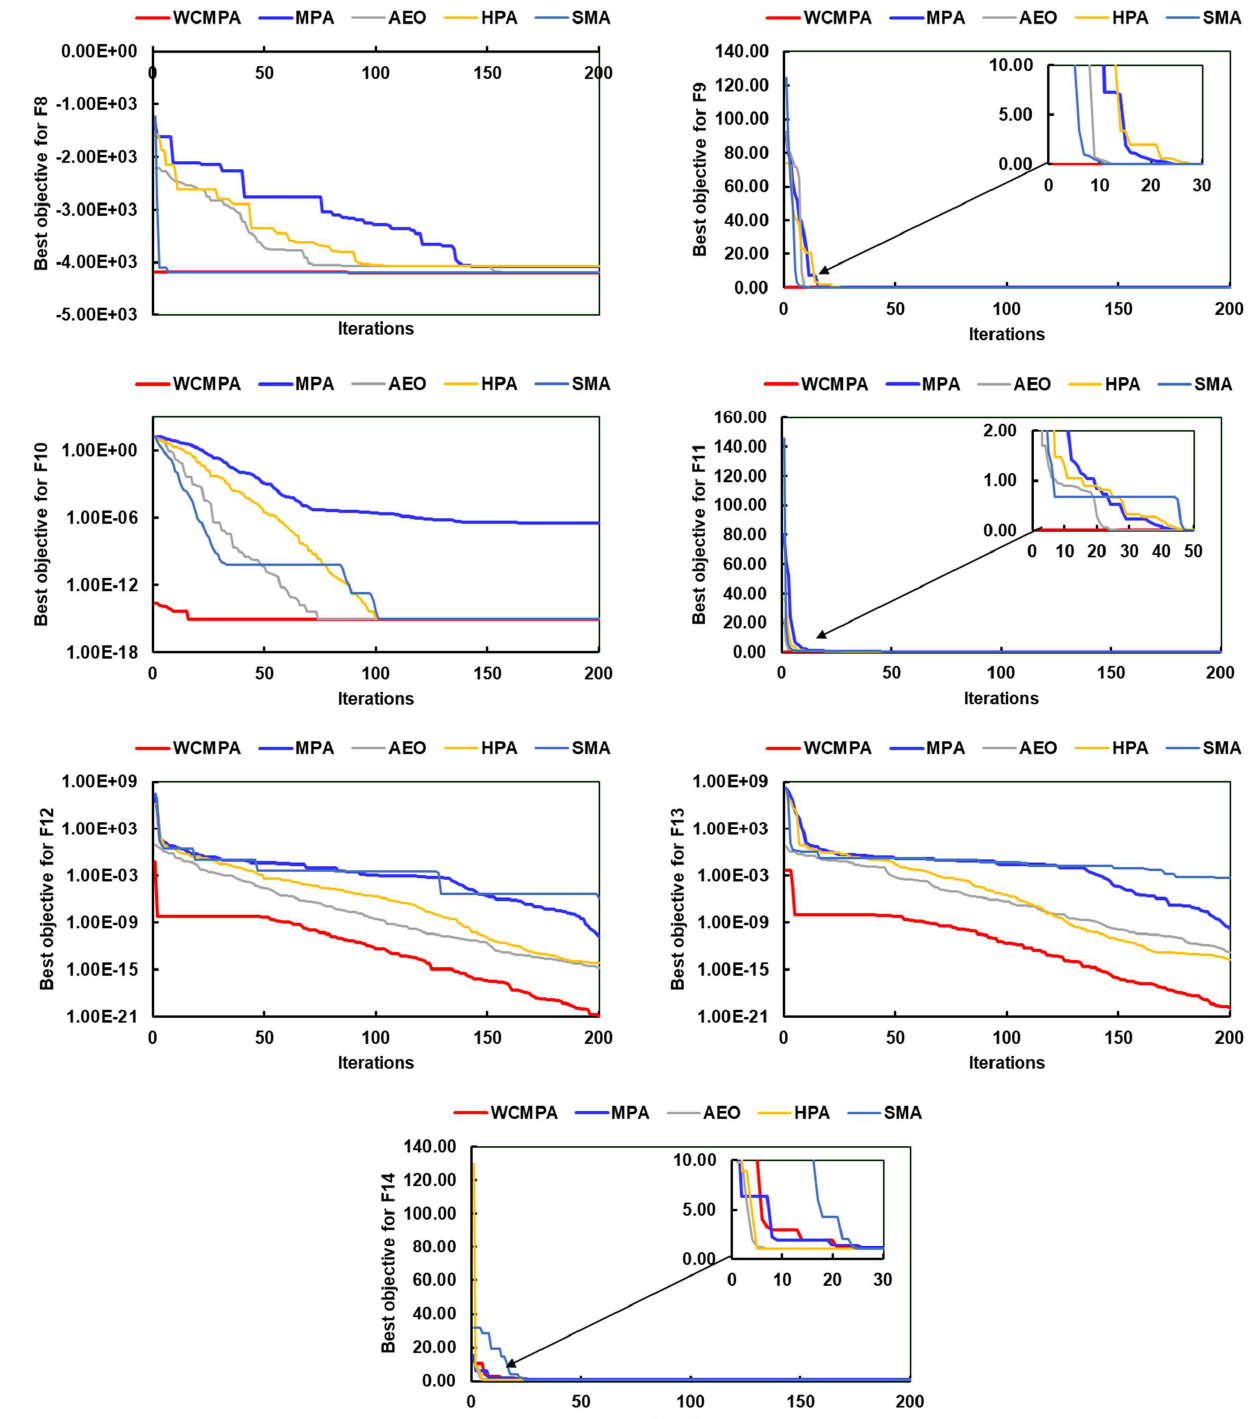
Figure 10. Multimodal benchmark functions. (E is the Scientific